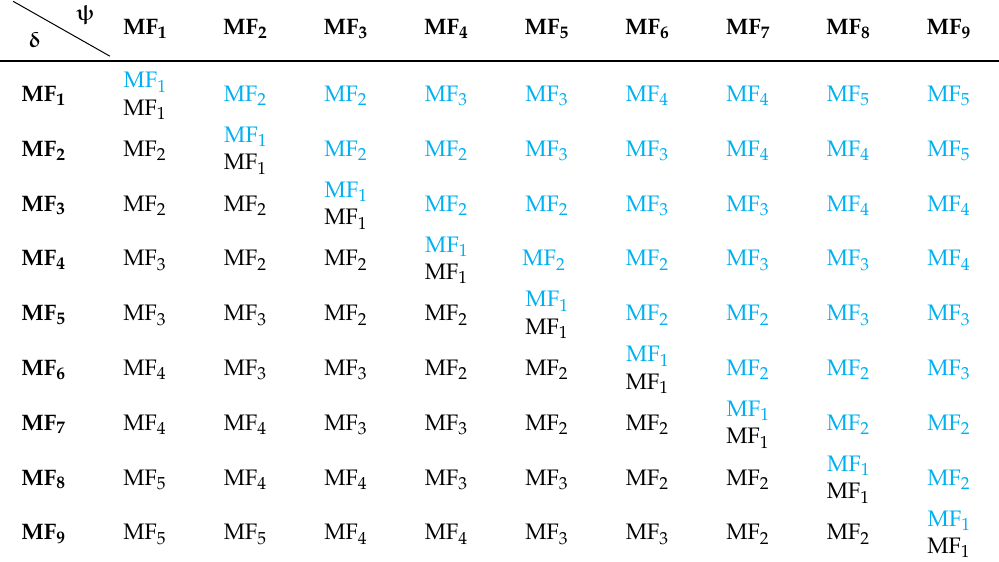
Table 4. Fuzzy linguistic rules for the ESP regulation: blue—left side of the vehicle, black—right side of the